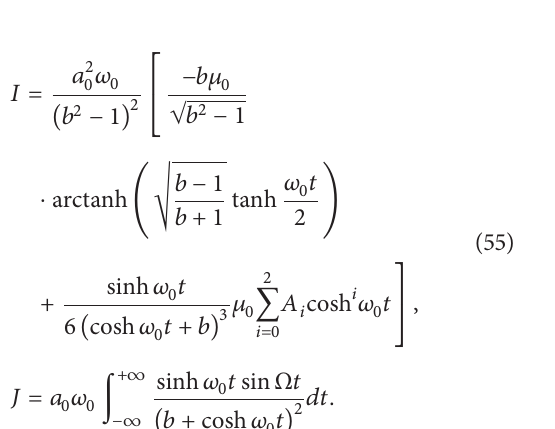
Figure 5: Lyapunov exponent diagram of (59) with 𝐹 = 3 .